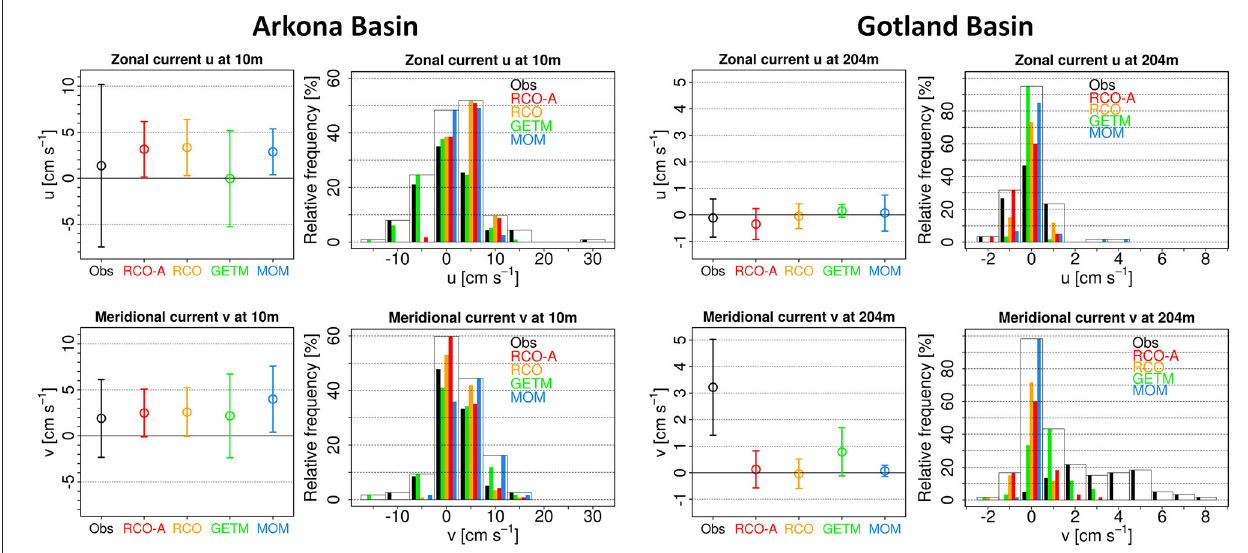
FIGURE 11 | Mean current velocities with their standard deviations as well as relative frequency of these velocities from observations (black) and model simulations (colors) in the Arkona Basin at 10m depth ( left ) and in the Gotland Basin at 204m depth ( right ). Results for zonal components are shown in the top panels and for meridional components in the bottom panels. See text for further